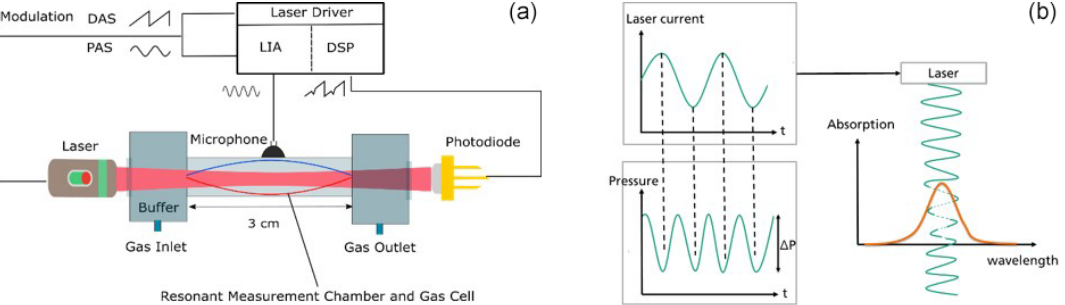
Figure 2. (a) Schematic setup of the combined DAS/PAS experiment. The photoacoustic signal is analysed with a lock-in amplifier (LIA), whereas the DAS signal of the photodiode is directly recorded and analysed by a digital signal processing (DSP) (b) modulation concept of PAS. Table 1. Selected absorption lines of CH 4 (ambient air contains 1.8ppm CH 4 ) and corresponding laser data. Line data are obtained from the HITRAN database (Rothman and Gordon, 2013). NIR MWIR LWIR Methane line selection